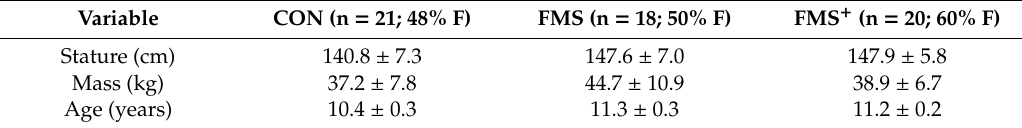
Table 1. Baseline characteristic data for the children included in each group.